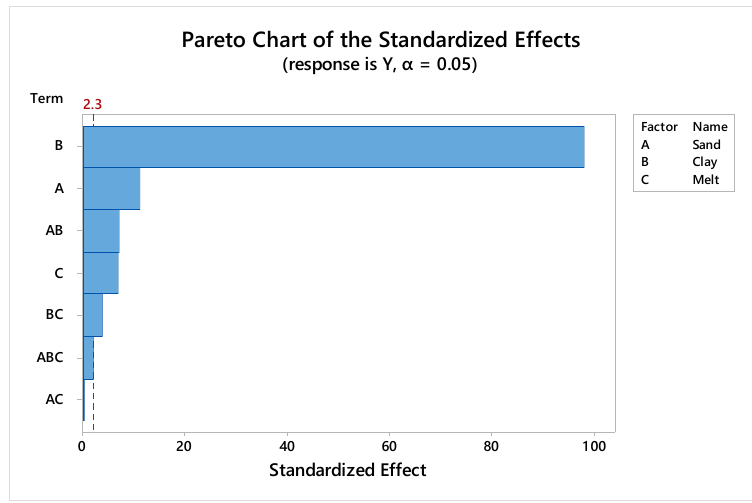
Figure 8. Pareto chart of Standardised effects.